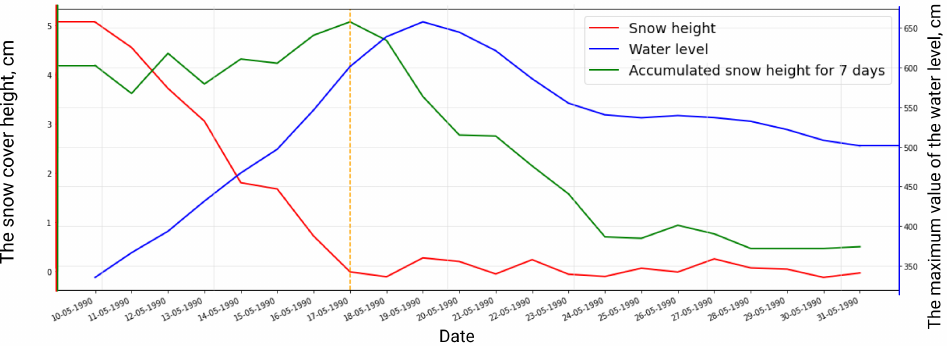
Figure 9. The amount and aggregated state of snow from 10 April 2020 to 30 April 2020. Green is the real amount of snow, red is aggregated state for past 7